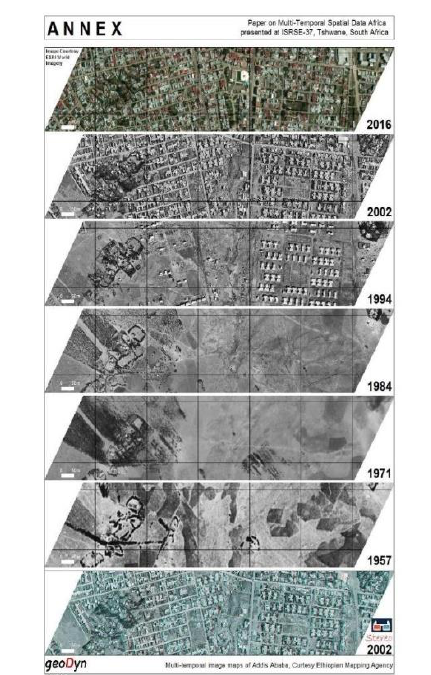
Figure 1. Multi-temporal image maps of Addis